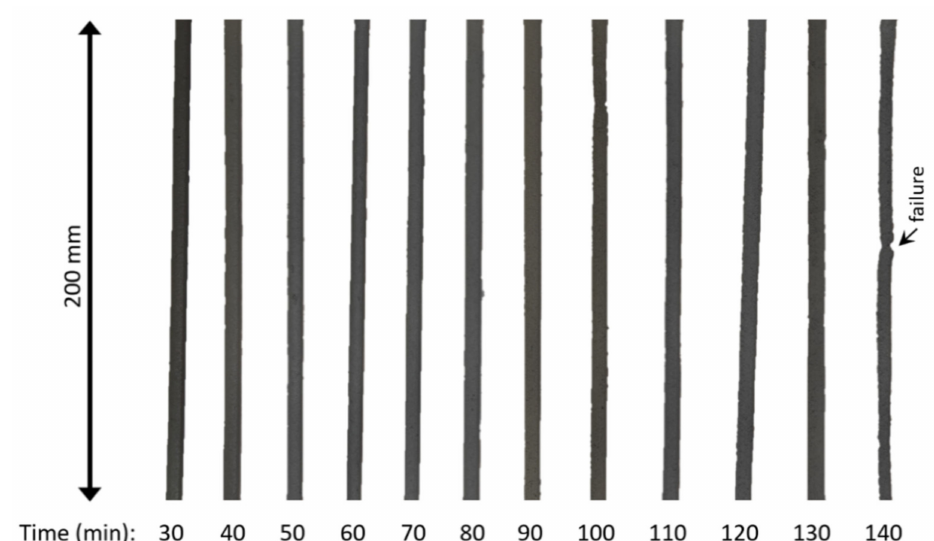
Figure 9. Example of filaments obtained in the printability test (0% TiO 2